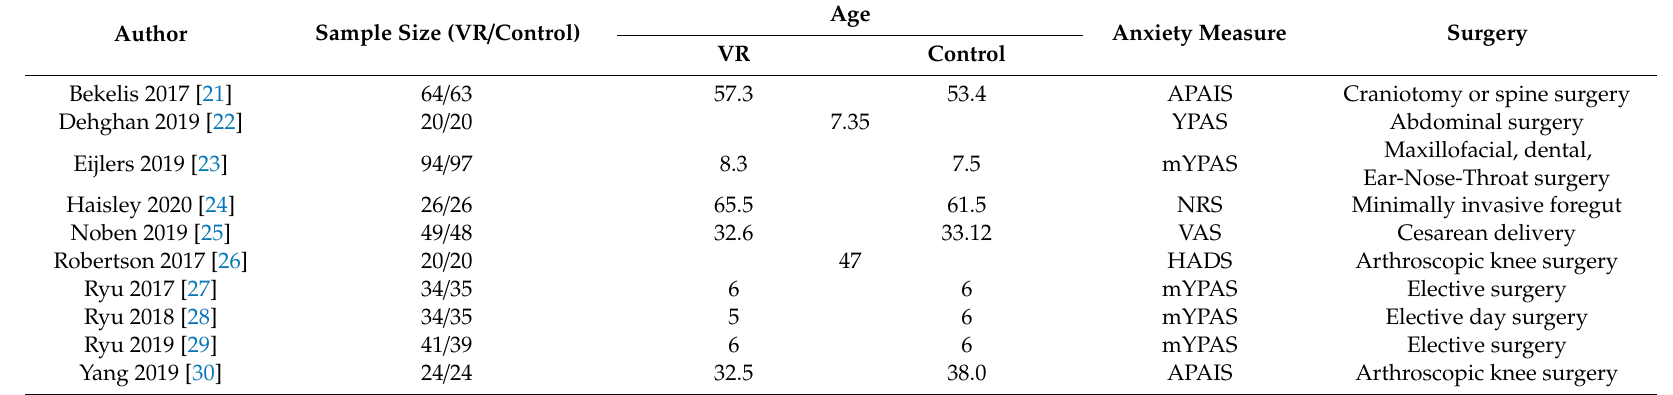
Table 1. Characteristics of included randomized controlled